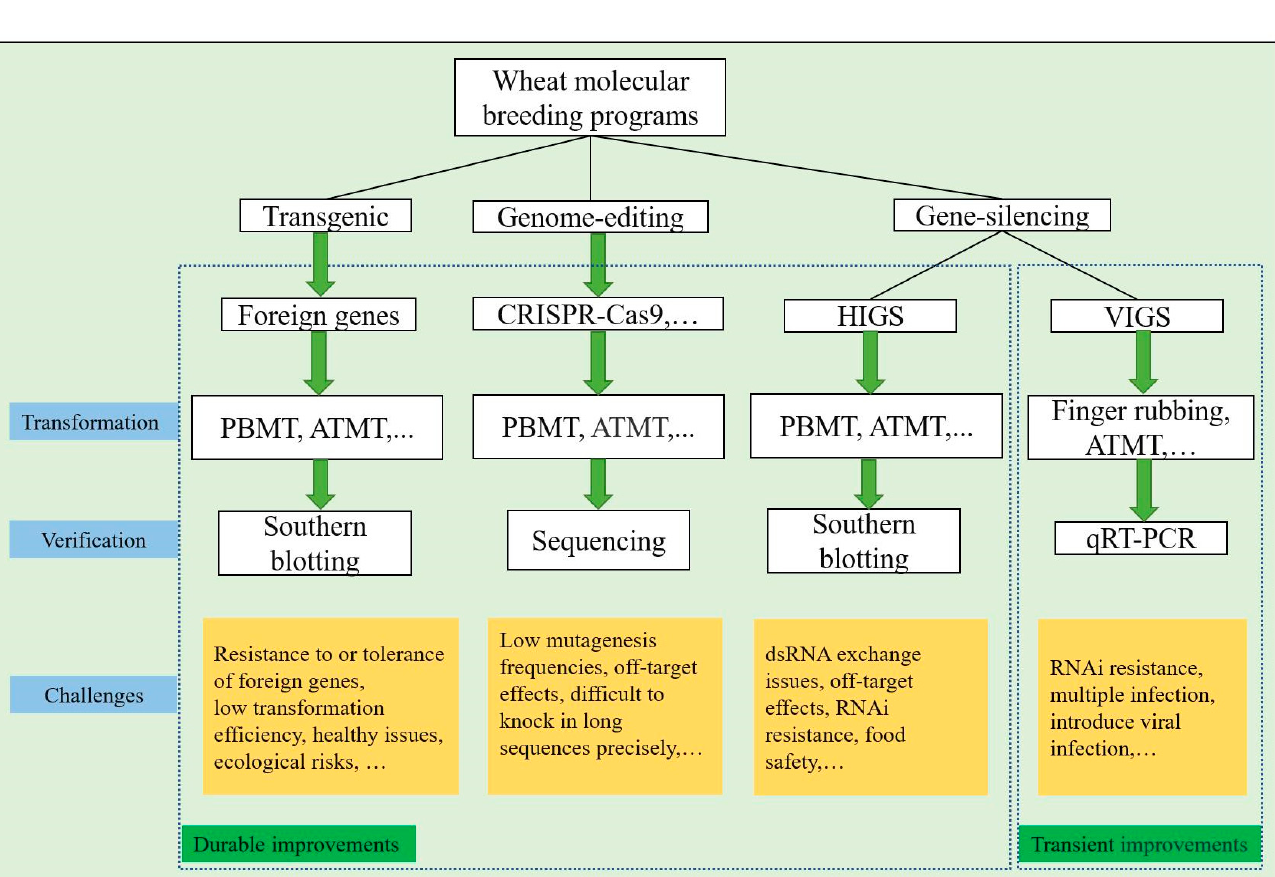
Figure 2. The principal stages and challenges of prevalent wheat germplasm improvement strate- gies of molecular breeding programs. The box on the left denotes the durable wheat improvement approaches and principal stages, while the box on the right denotes the transient wheat improve- ments. The pathways supported by experimental evidence from the literature. ATMT, Agrobacterium tumefaciens -mediated transformation; PBMT, particle bombardment mediated transformation; HIGS, host-induced gene silencing; VIGS, virus-induced gene silencing; qRT–PCR, real-time polymerase chain reaction.